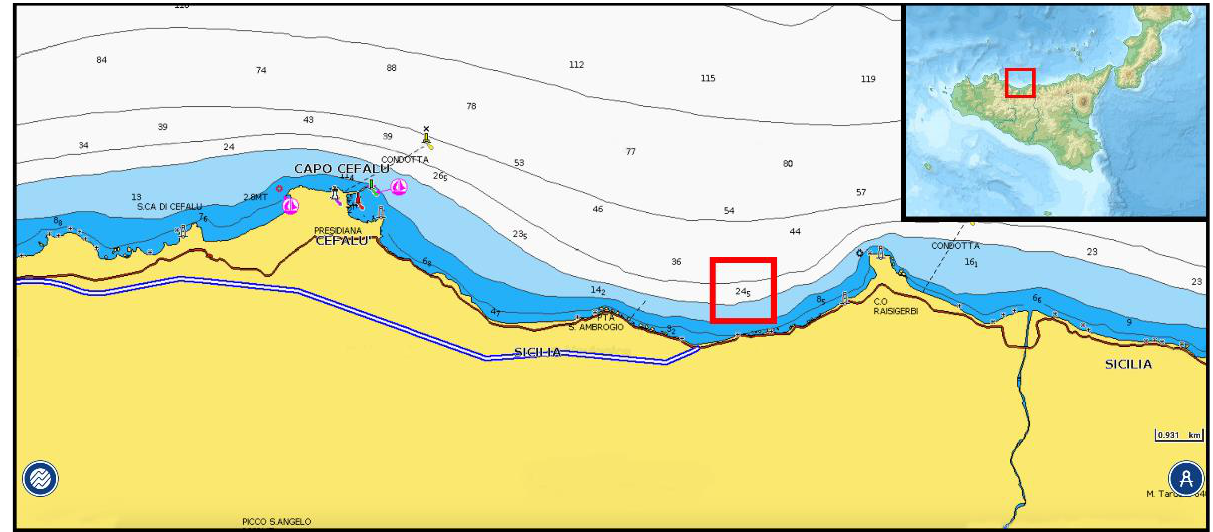
Figure 1. Area of study (empty square) in presence of the ghost nets, in Gulf of Cefalù, northern coast of Sicily, Tyrrhenian Sea, Italy. The geographical coordinates (38.031065° N, 14.098783° E) were reported.